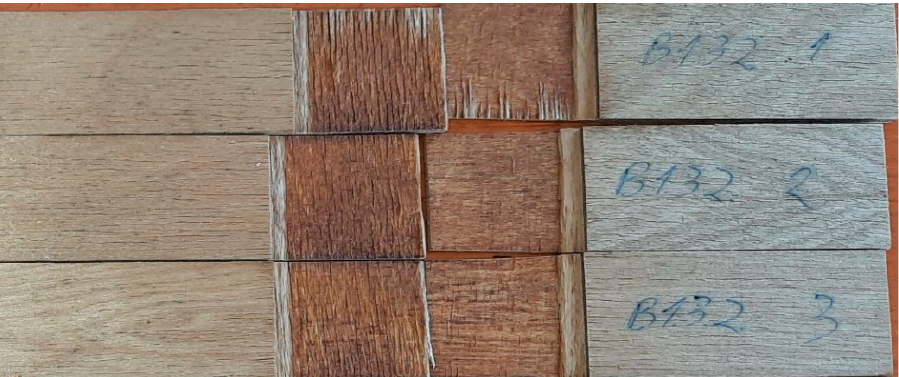
Figure 12. Scheme of the plywood specimen for the test (A) and experimentally obtained plywood specimen after the shear strength test.